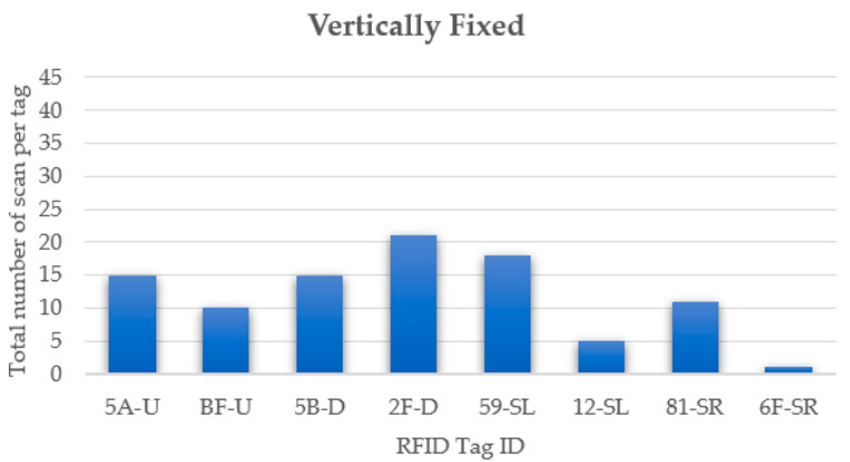
Figure 13. The total number of scans per tag type and orientation when the sUAS was flown back and forth at a fixed height over tags on the ground (VF) for 1 min.